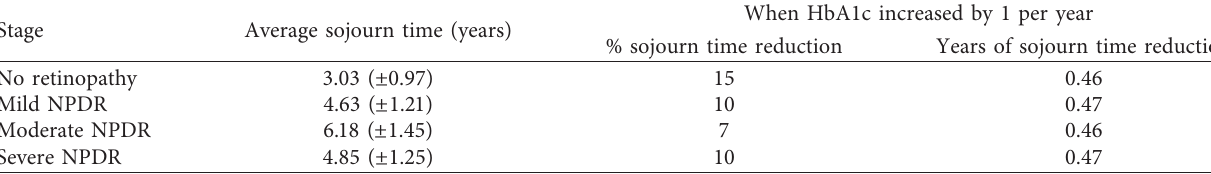
Table 6: Average sojourn time ( ± SD) and the effect on HbA1c for each stage.